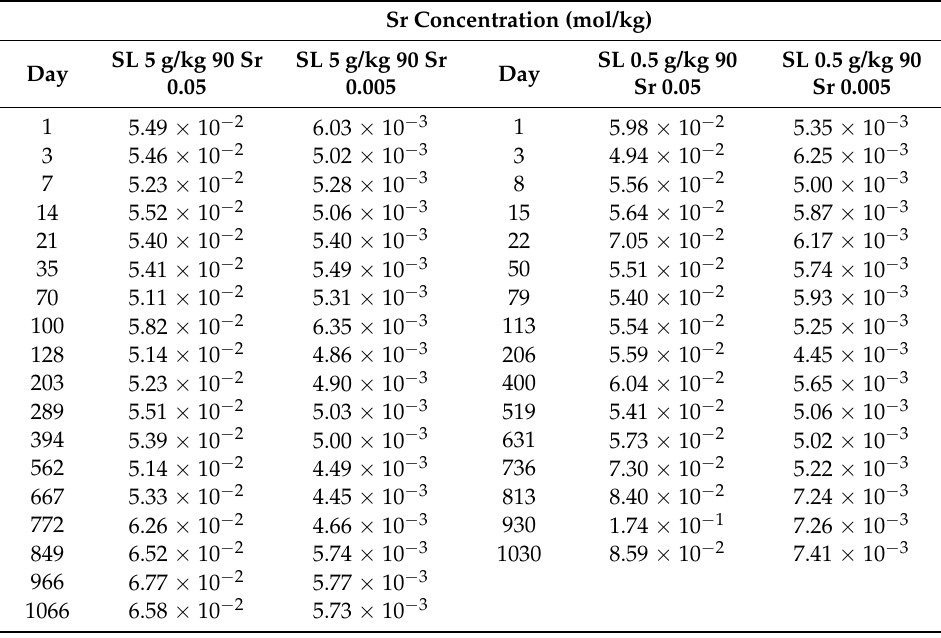
Table A6. Sr concentration of experiments with Sr in the aqueous solution at 90 ◦ C. Sr Concentration (mol/kg)